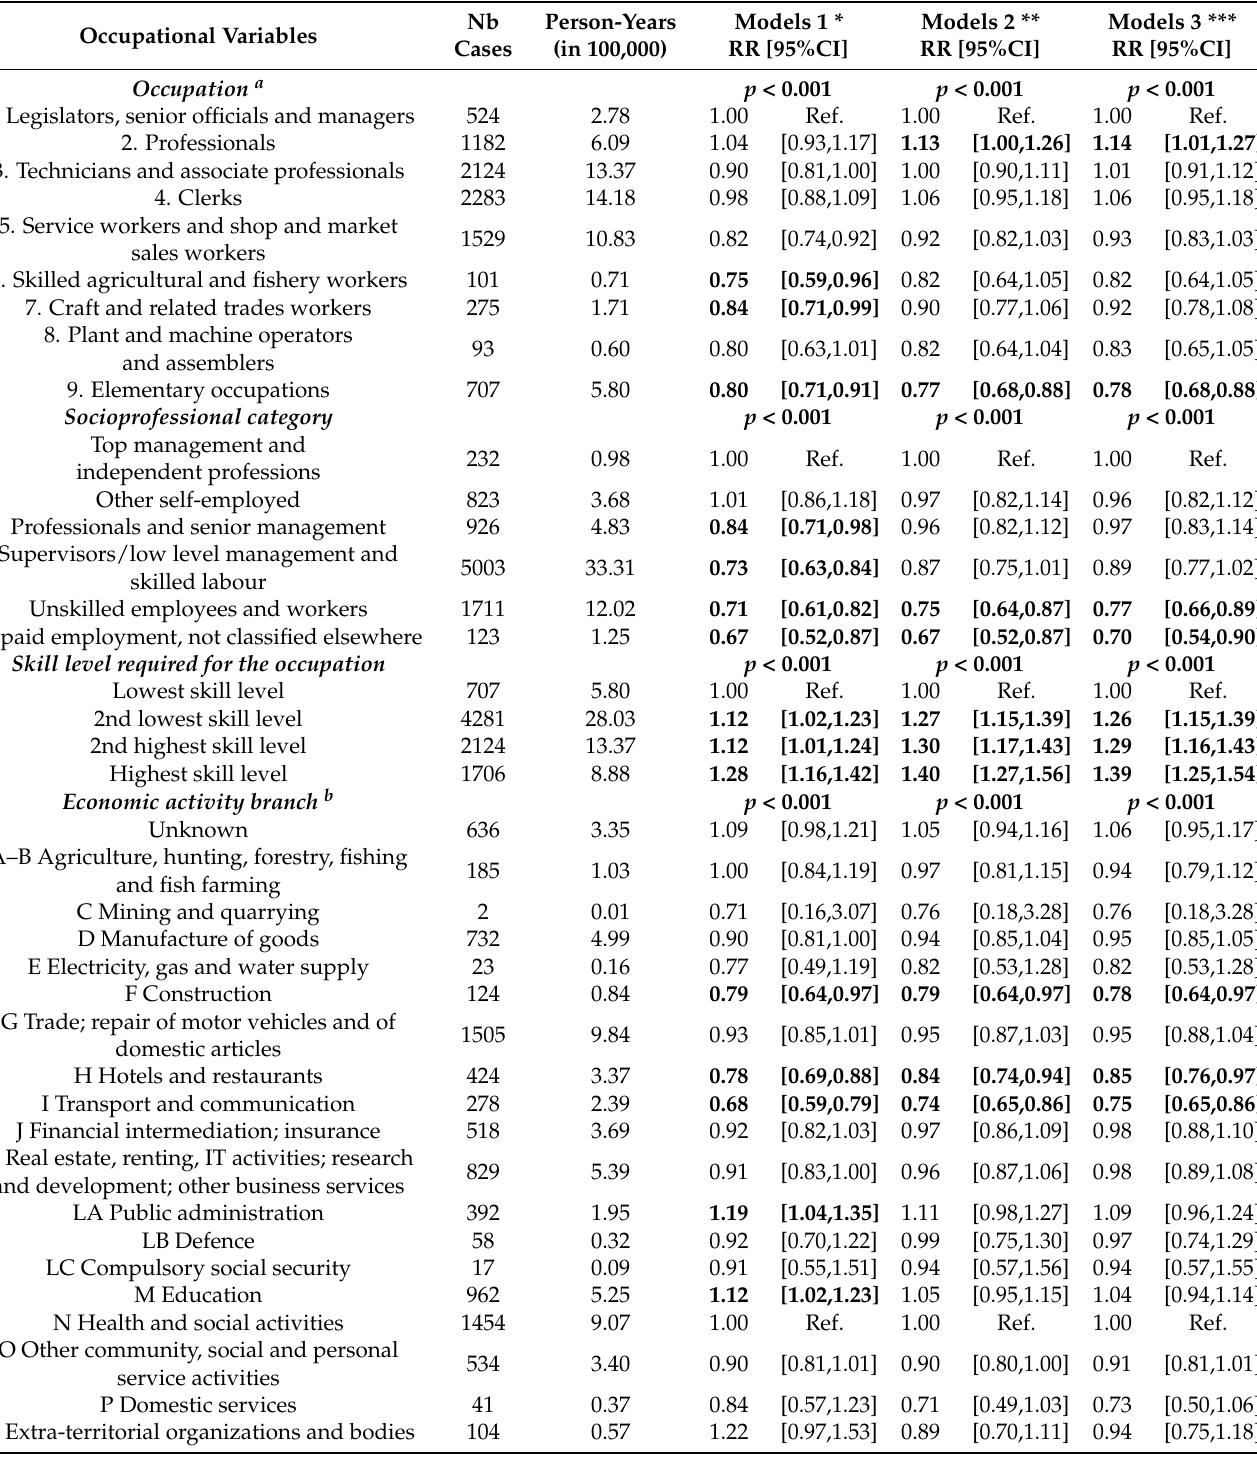
Table 2. Relative risk (RR) with confidence interval (95%CI) of breast cancer by occupational, socio- professional, economic activity and skill level category, among females aged 18–85 years in Swiss cantons of Neuch â tel, Geneva, Vaud and Wallis,